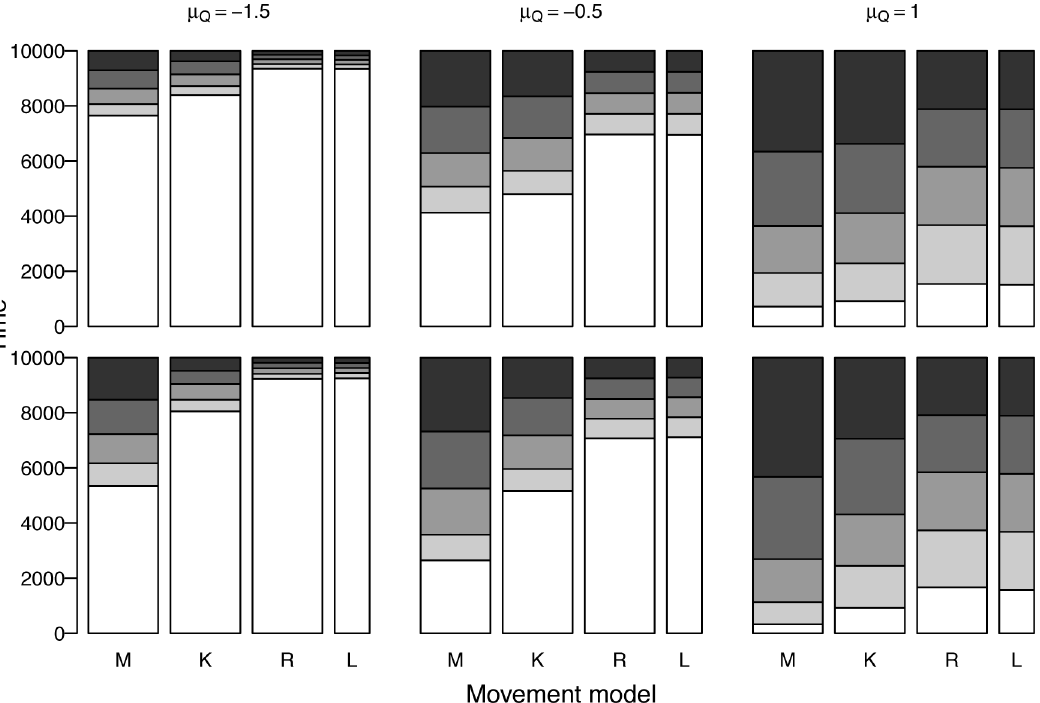
Fig 4. Time spent in areas of different resource quality across different landscape parameters patch concentration μ Q and size γ Q for medium regeneration rate β R = 0.01 compared to the distribution of resources on the landscape. White represents zero resources while shades of gray from light to dark show quartiles of increasing quality. The memory model is parameterized with best overall parameters, ϕ L = 1 e − 05, ϕ S = 0.01, ψ M = 2, γ Z = 10. In the figure, M = memory, K = kinesis, R = random walk, L = landscape.